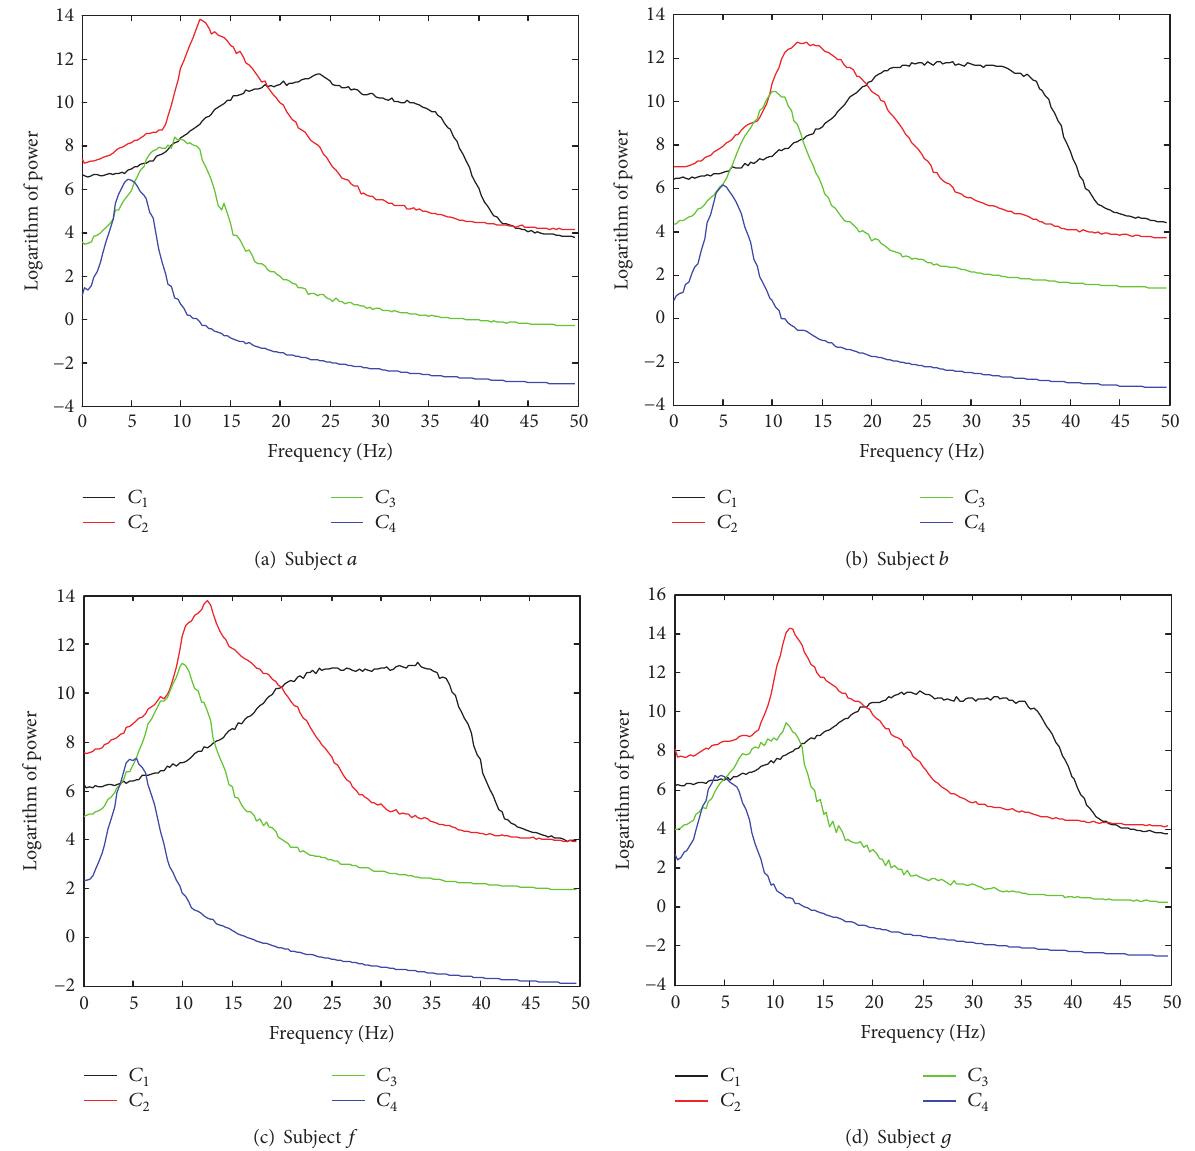
Figure 6: The average power spectra of 𝐶 1 ∼ 𝐶 4 for all four subjects in BCI Competition IV Dataset I. Note that our method computes the average power spectra from the identified information-bearing IMFs at the first four scales for all 200 trials of each